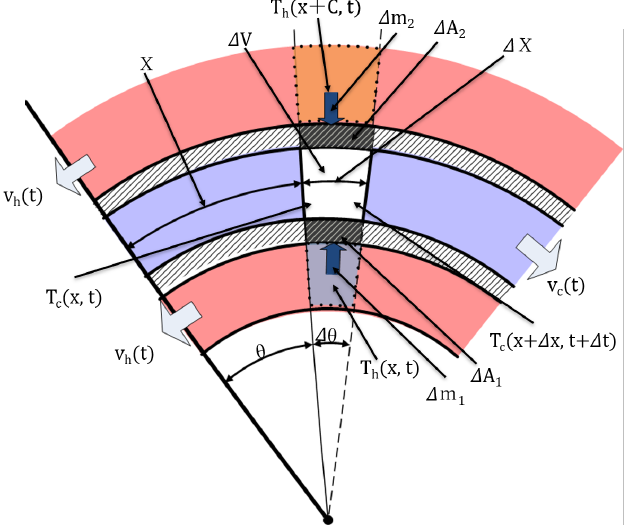
Figure 3. The principle of heat transfer for the spiral heat